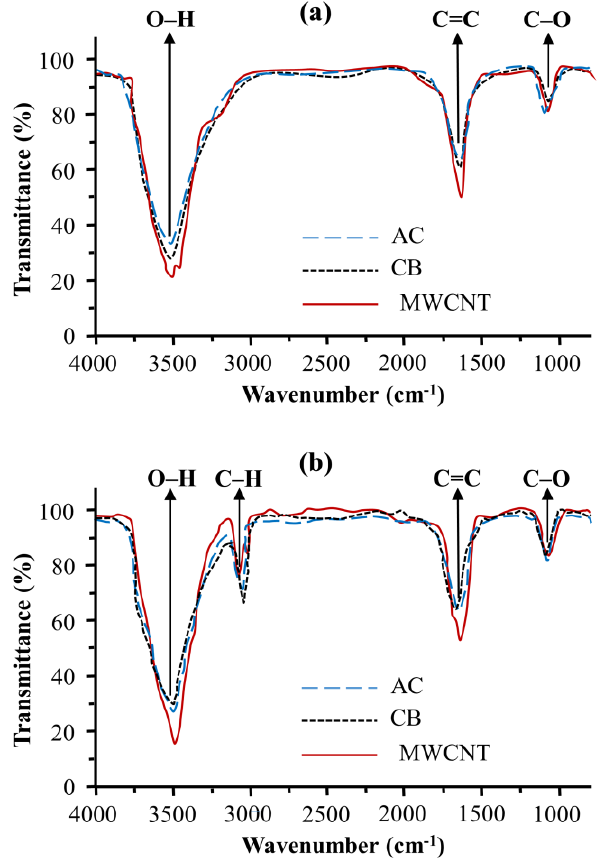
Fourier-transform infrared (FTIR) spectra of carbon materials: ( a ) before and ( b ) after treatment.